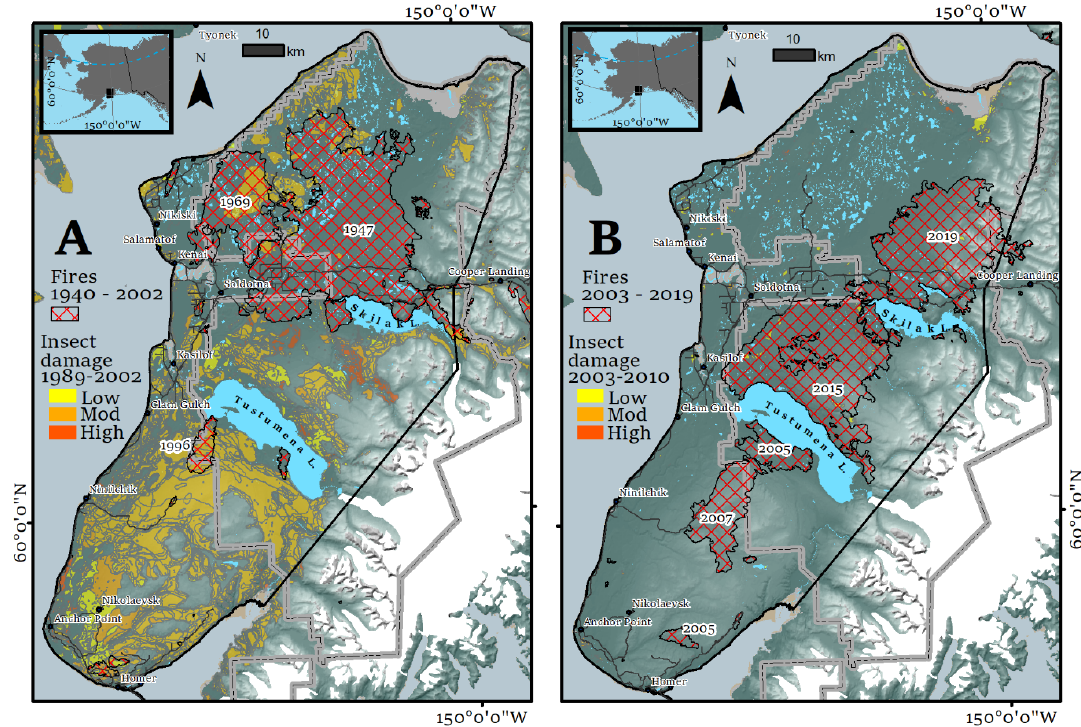
Figure 6. Spatial distribution of wildfire occurrence and spruce bark beetle-caused tree mortality for two time frames determined by available data: ( A ) 1940–2002 and ( B ) 2003–2019.